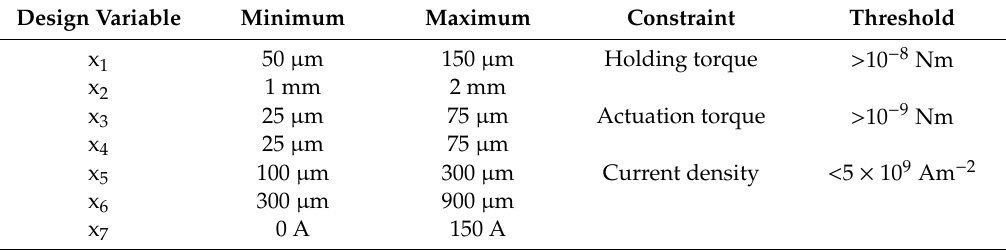
Table 1. Variation ranges of the design variables and